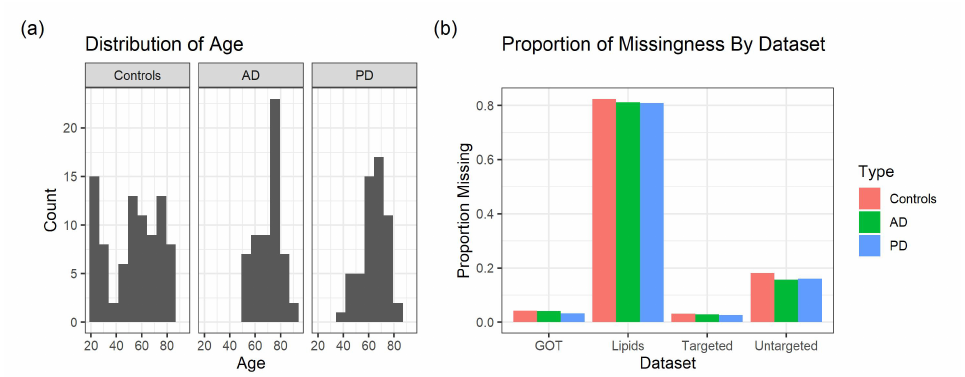
Figure A1. ( a ) Distribution of subject age, split by phenotype; ( b ) a comparison of missingness between profiles, split by